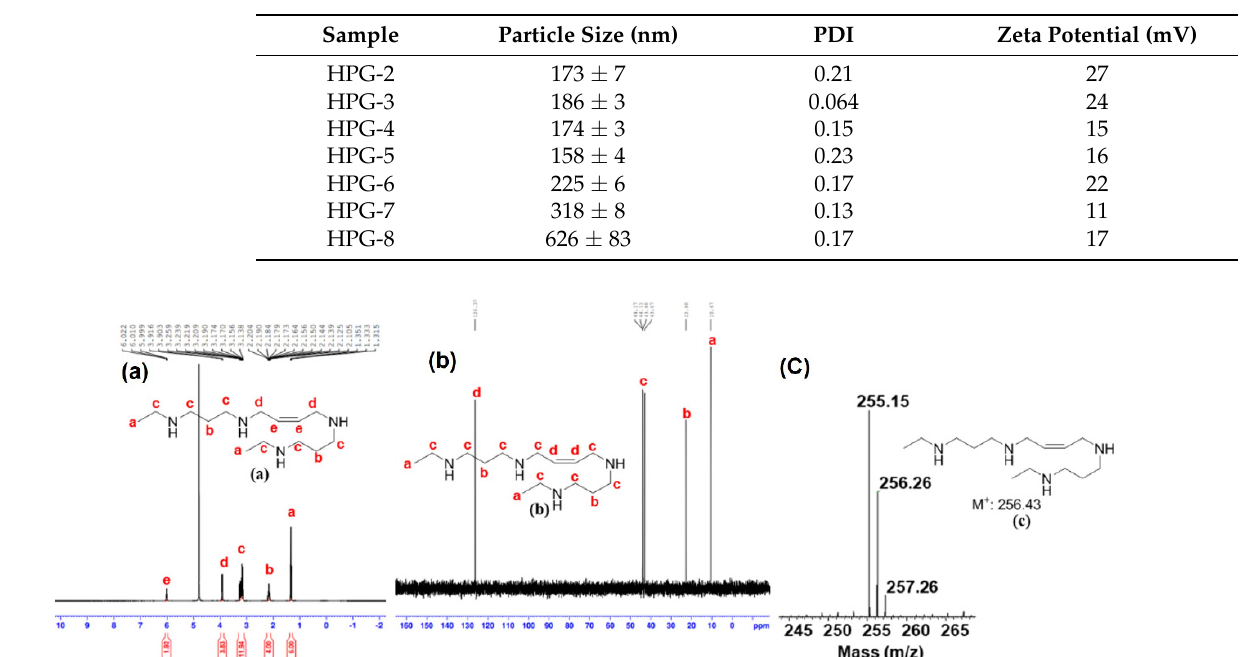
Table 1. Hydrodynamic size and zeta potential of self-assembled HPG analogs.